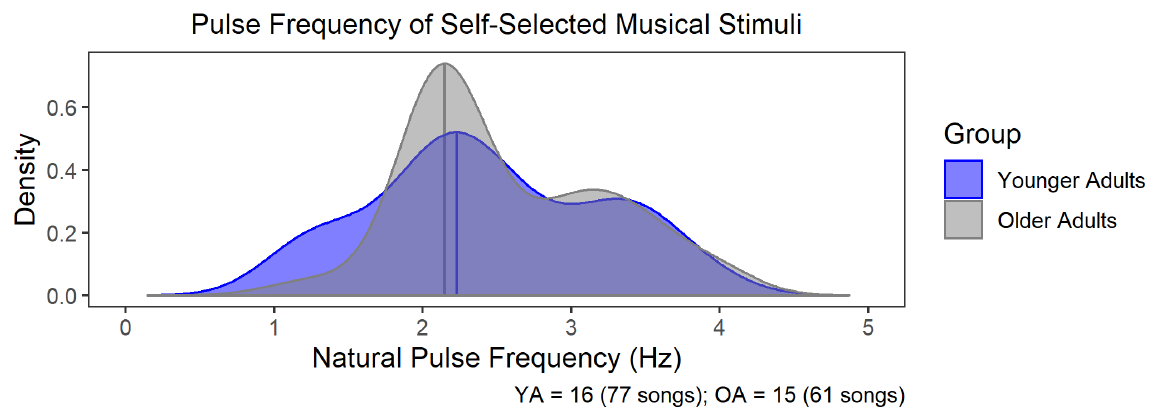
Figure 2. Natural pulse frequencies in participant-selected music. Probability density functions (PDFs) of natural pulse frequencies for younger (YA; blue) and older (OA; grey) adults’ self-selected musical recordings that survived the music-feature analysis. Younger adults (N = 16, 77 musical recordings) and older adults (N = 15, 61 musical recordings) exhibited similar distributions of natural pulse frequencies in their self-selected music, with a prominent mode emerging at ~2 Hz, prior to the pulse normalization of the PLVs. A Kolmogorov–Smirnov test of the pulse-frequency distributions suggested that the distributions of the natural pulse frequencies did not significantly differ between the YA and OA